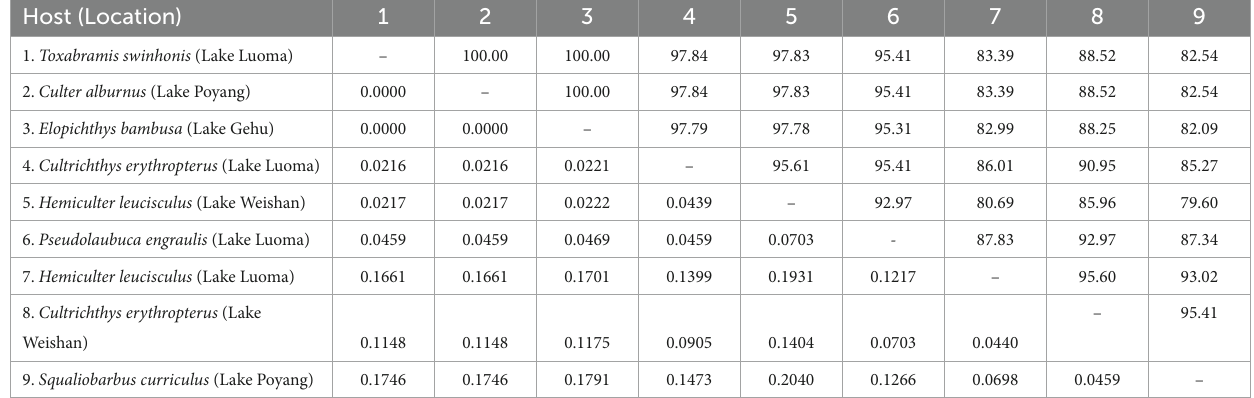
TABLE 4 Pairwise nucleotide sequence identity (upper right) values and evolutionary distances (left bottom) among P. alburnus isolates isolated from different hosts and locations by Kimura-2 Parameter analysis based on ITS rDNA